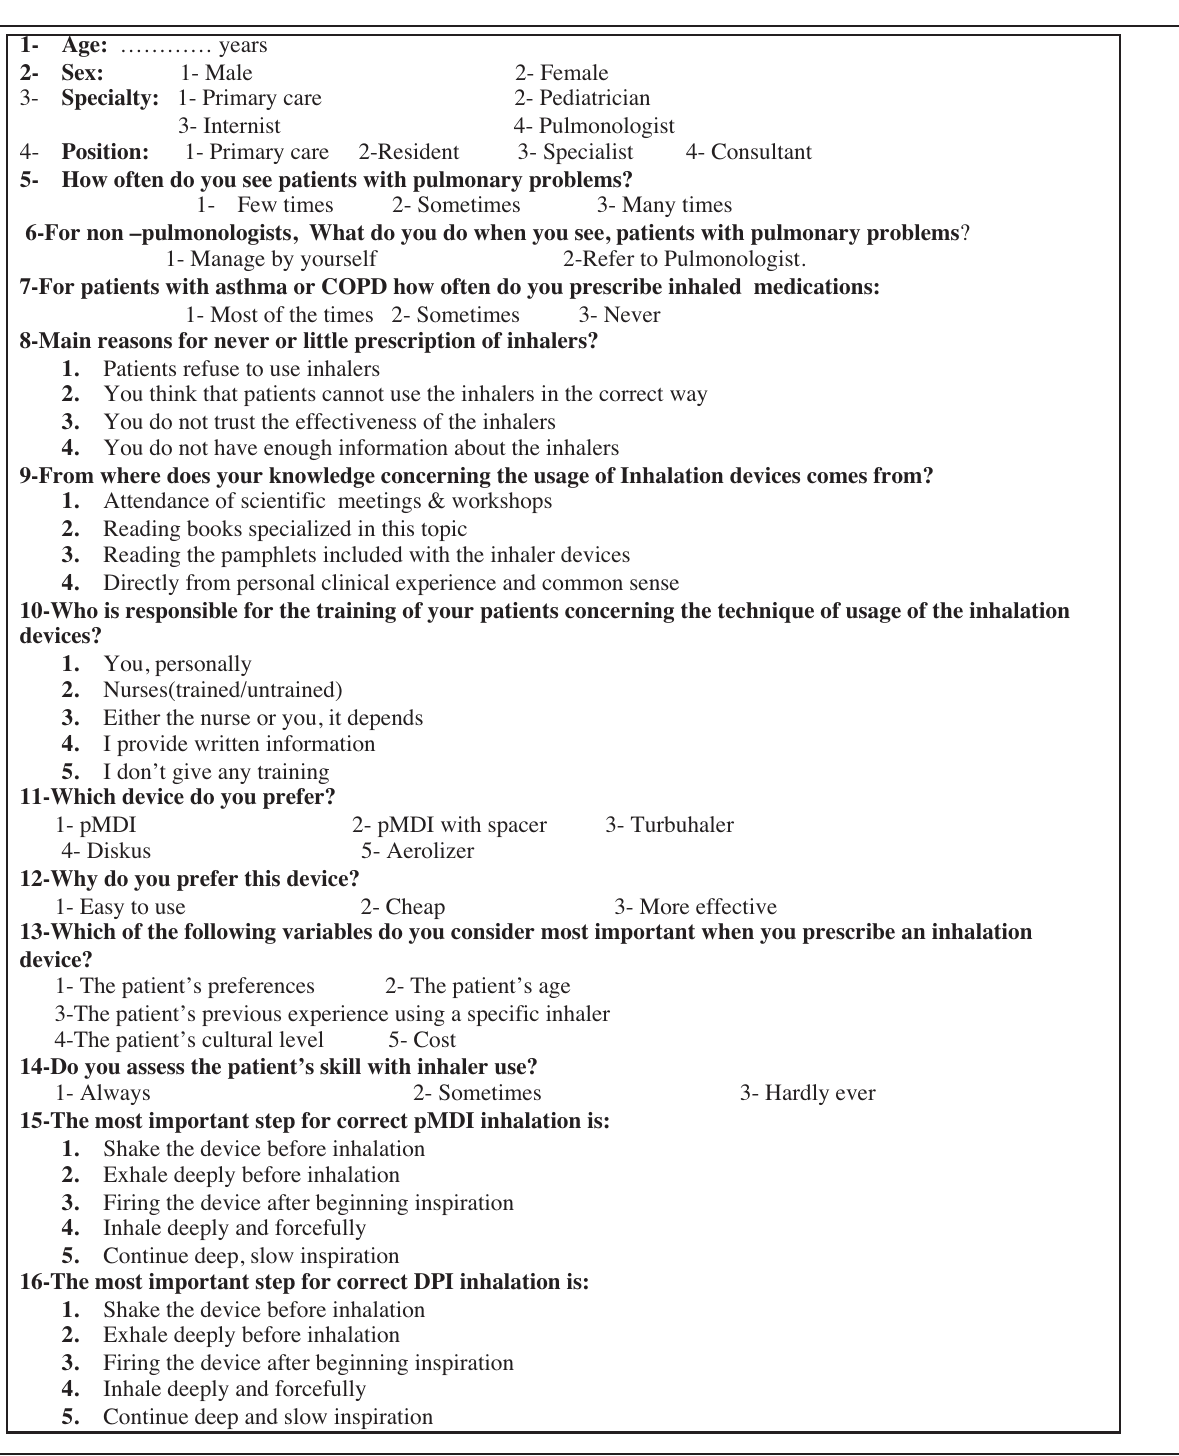
Table 1A Questionnaire administered to the studied